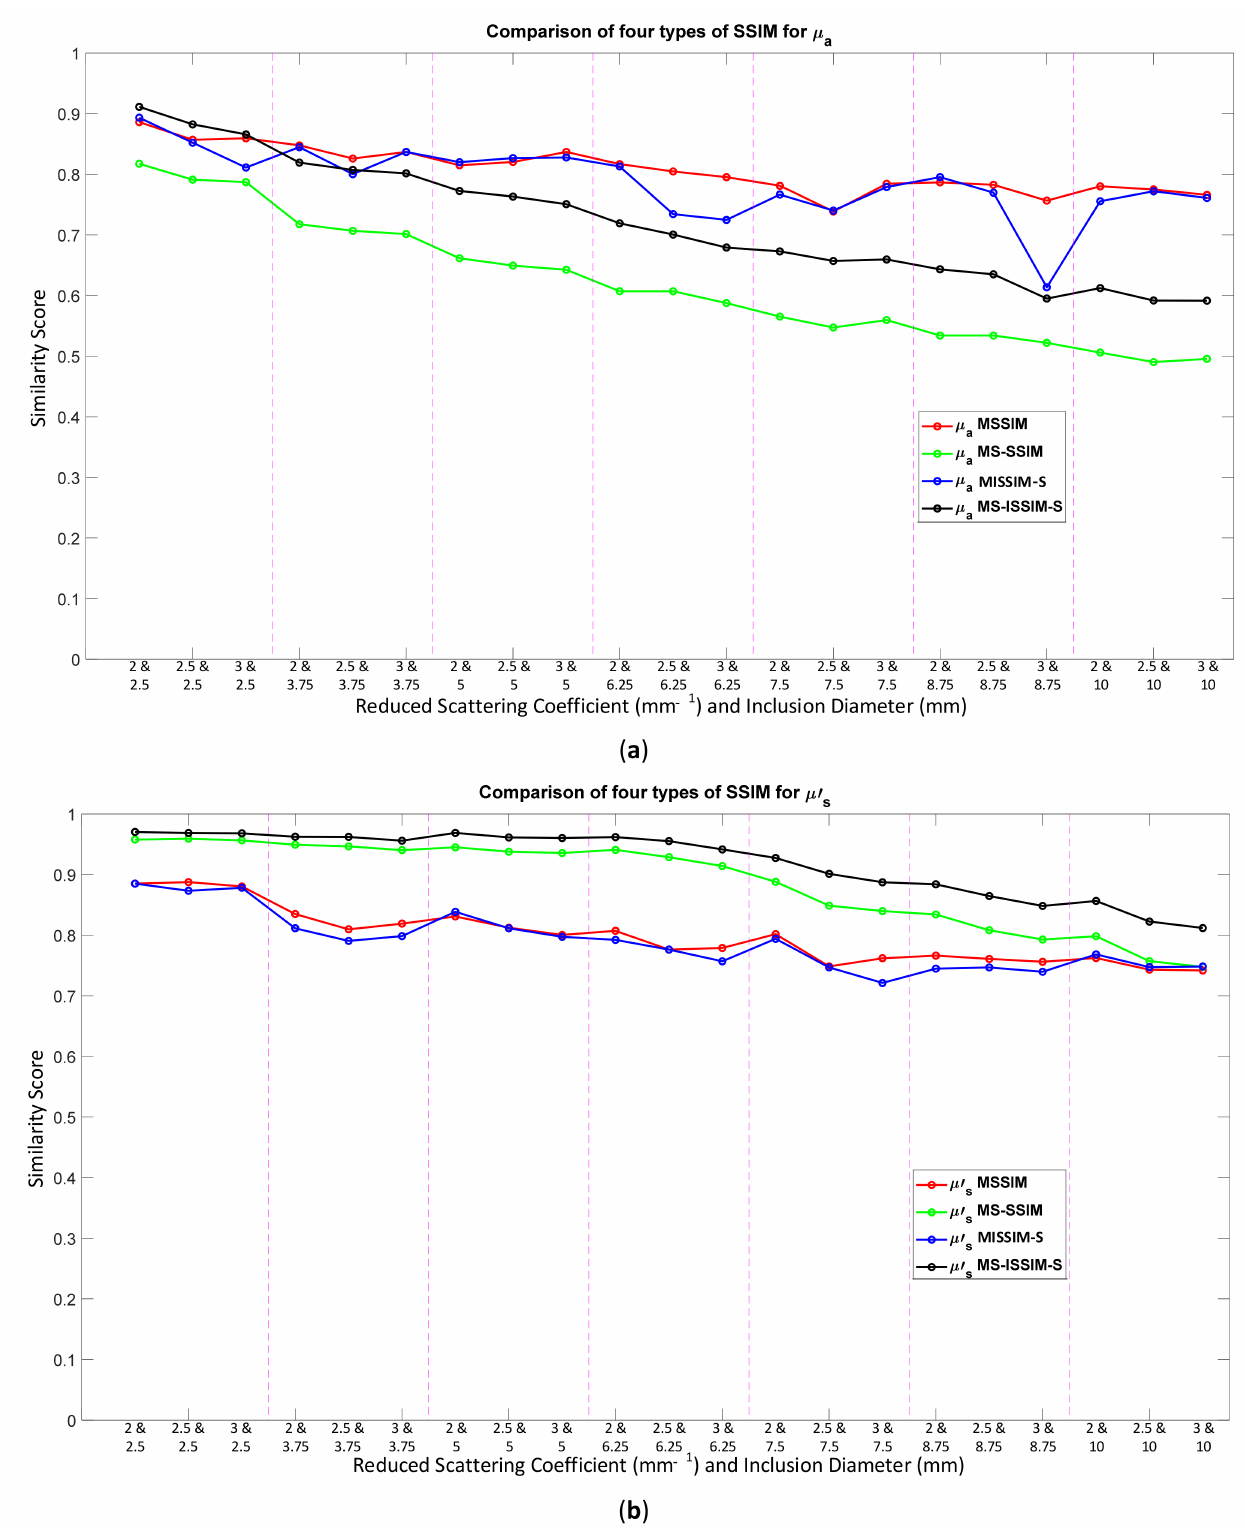
Figure 13. Four types of SSIM similarity score of case B1 with 1% noise amplitude for ( a ) µ a and ( b ) µ (cid:48) s